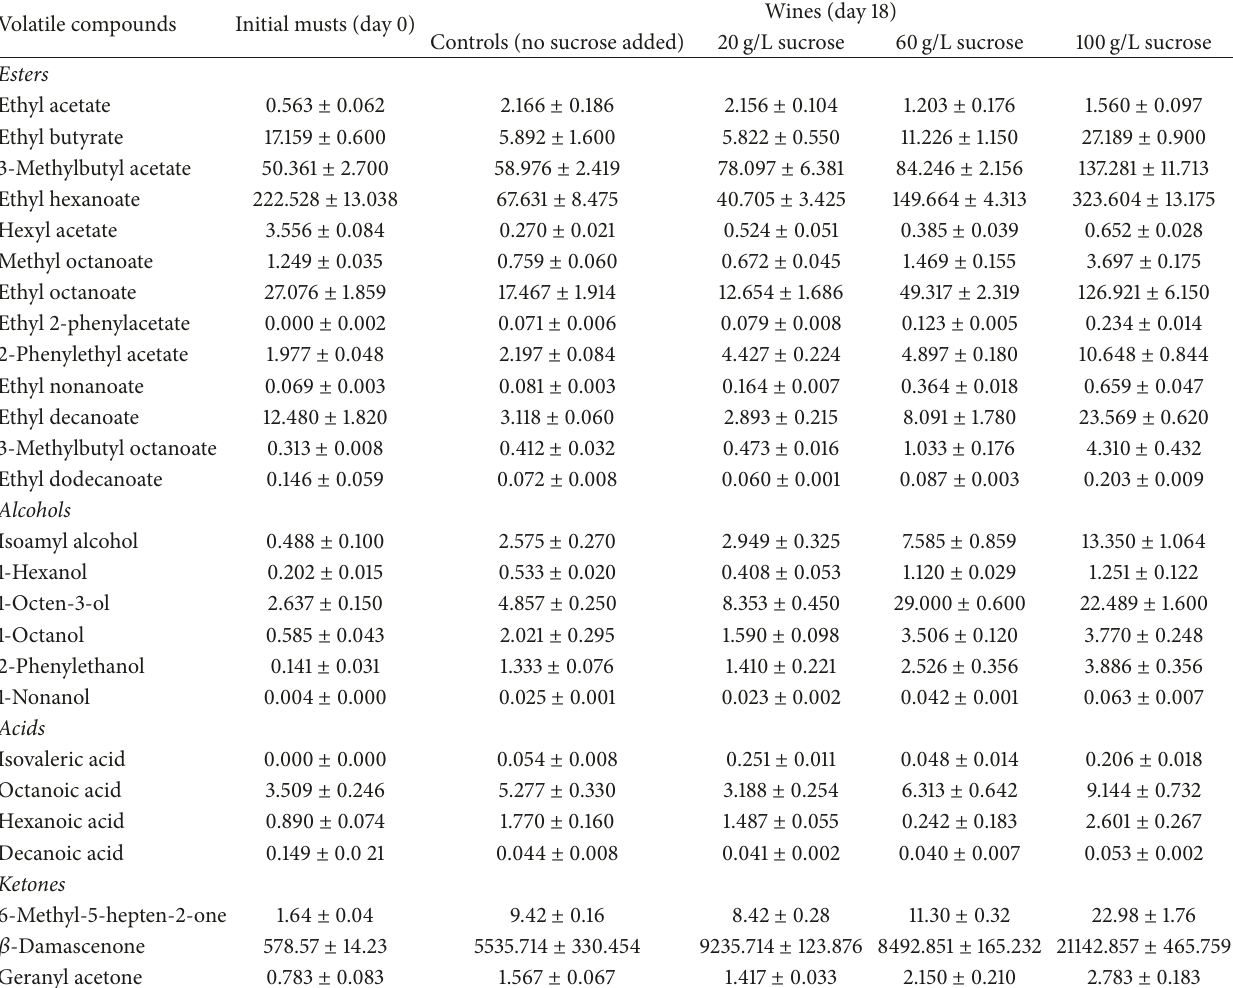
Table 3: Odour activity values (OAVs) of major volatile compounds in the initial musts (day 0) and wines added with sucrose and controls (day